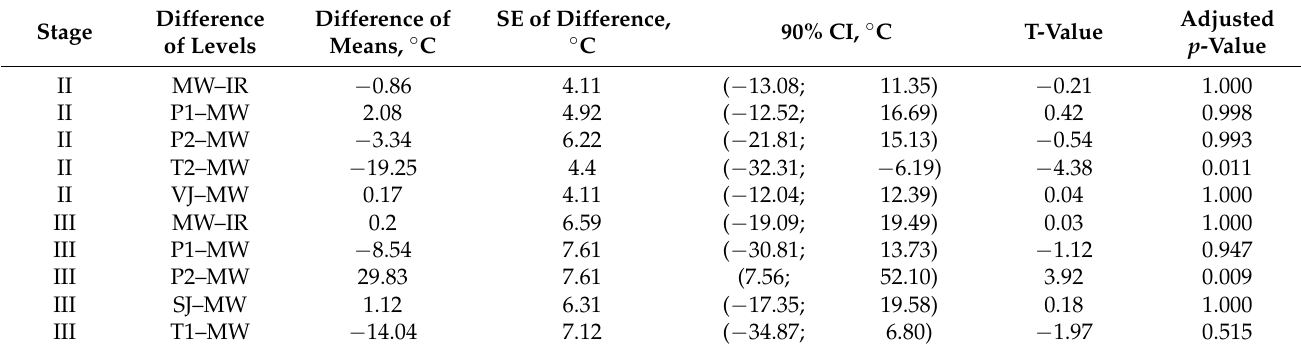
Table 9. Tukey’s pairwise comparison for TSRST test–crack